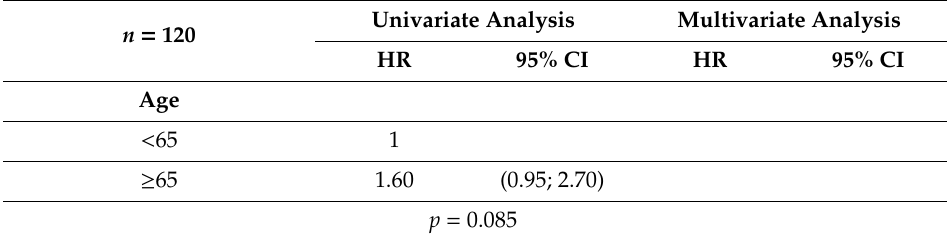
Table 4. Prognostic factors of long survival in univariate and multivariate